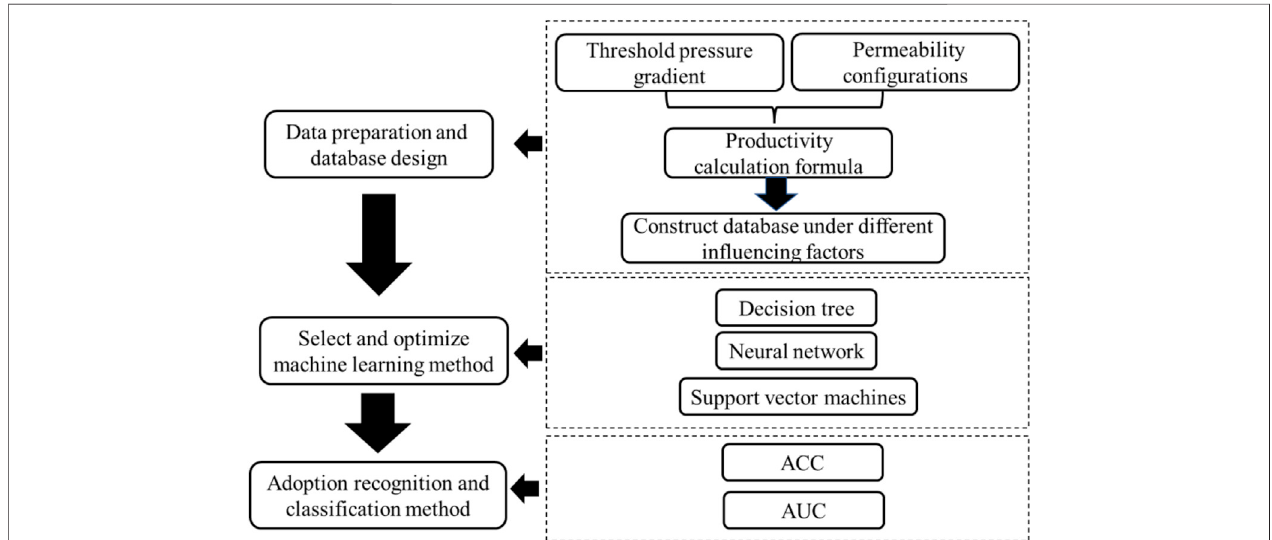
FIGURE 1 | The speci fi c research